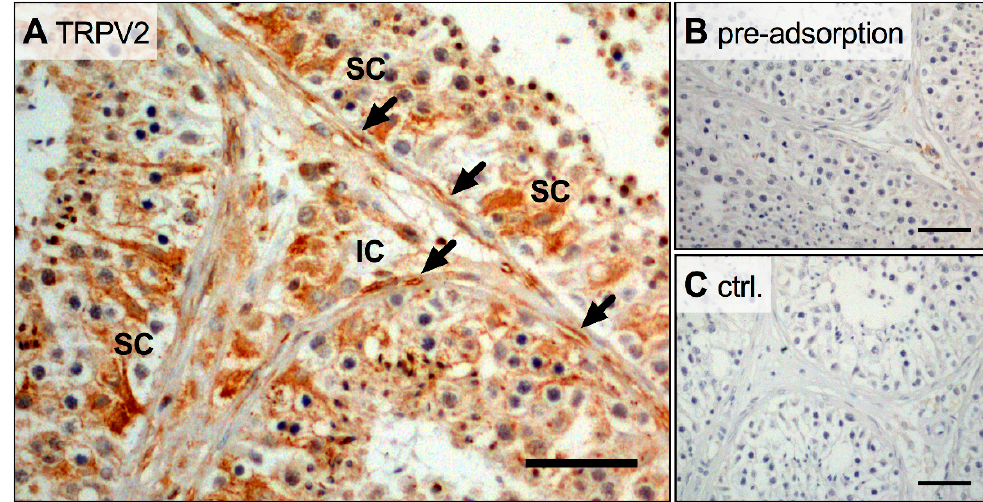
Figure 2. Broad expression of TRPV2 in human testis. ( A – C ) In human testicular slices, immunohistochemistry showed TRPV2 signals in Sertoli (SC), interstitial (IC) and in peritubular cells (arrows). In both controls, pre-adsorption with TRPV2 peptide ( B ) and omission of the primary antibody ( C ), no TRPV2 signal could be detected. Scale bar 100 µm.